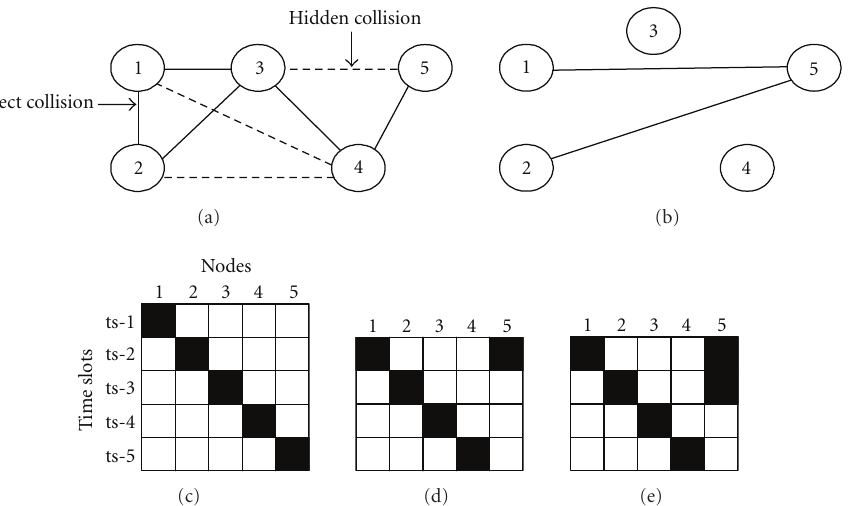
Figure 1: (a) Graph of a five-node ad hoc network, (b) complement graph of the five-node network, (c) trivial TDMA broadcast schedule, (d) and (e) optimal TDMA